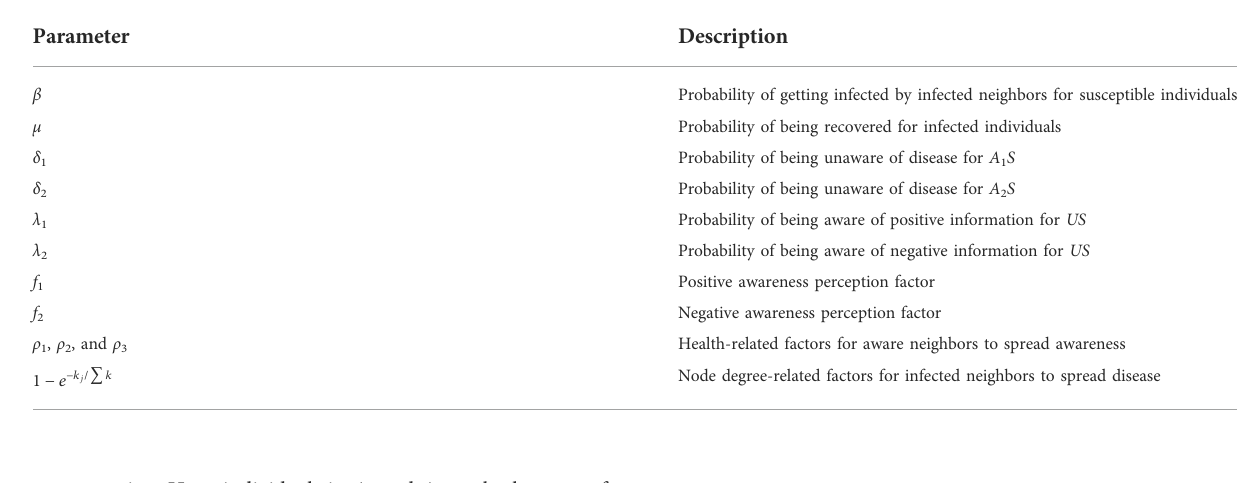
TABLE 1 De fi nitions of key parameters.